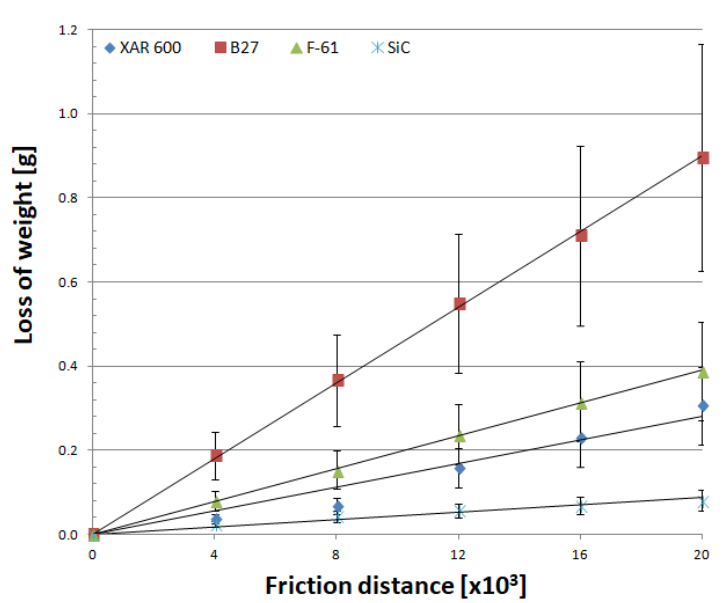
Figure 7. Mass wear as a function of friction distance for materials in light soil.